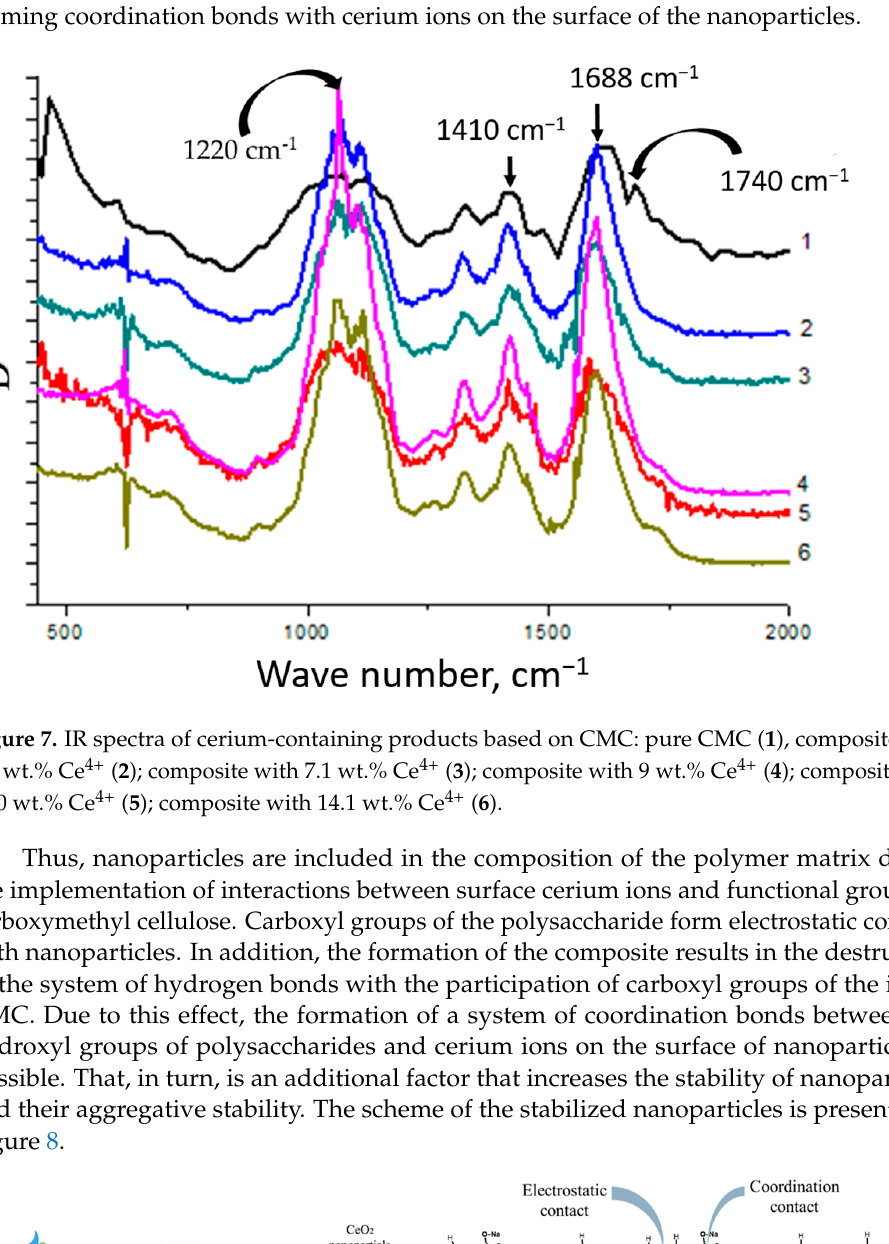
Figure 6. SEM image of cerium-containing products based on CMC: composite with 6.4 wt.% Ce 4+ ( 1 ); composite with 7.1 wt.% Ce 4+ ( 2 ); composite with 9 wt.% Ce 4+ ( 3 ); composite with 11.0 wt.% Ce 4+ ( 4 ); composite with 14.1 wt.% Ce 4+ ( 5 ).